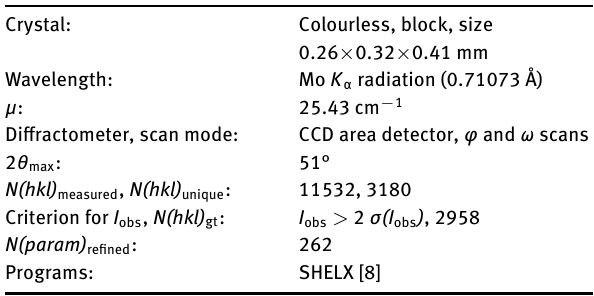
Table 1: Data collection and handling.